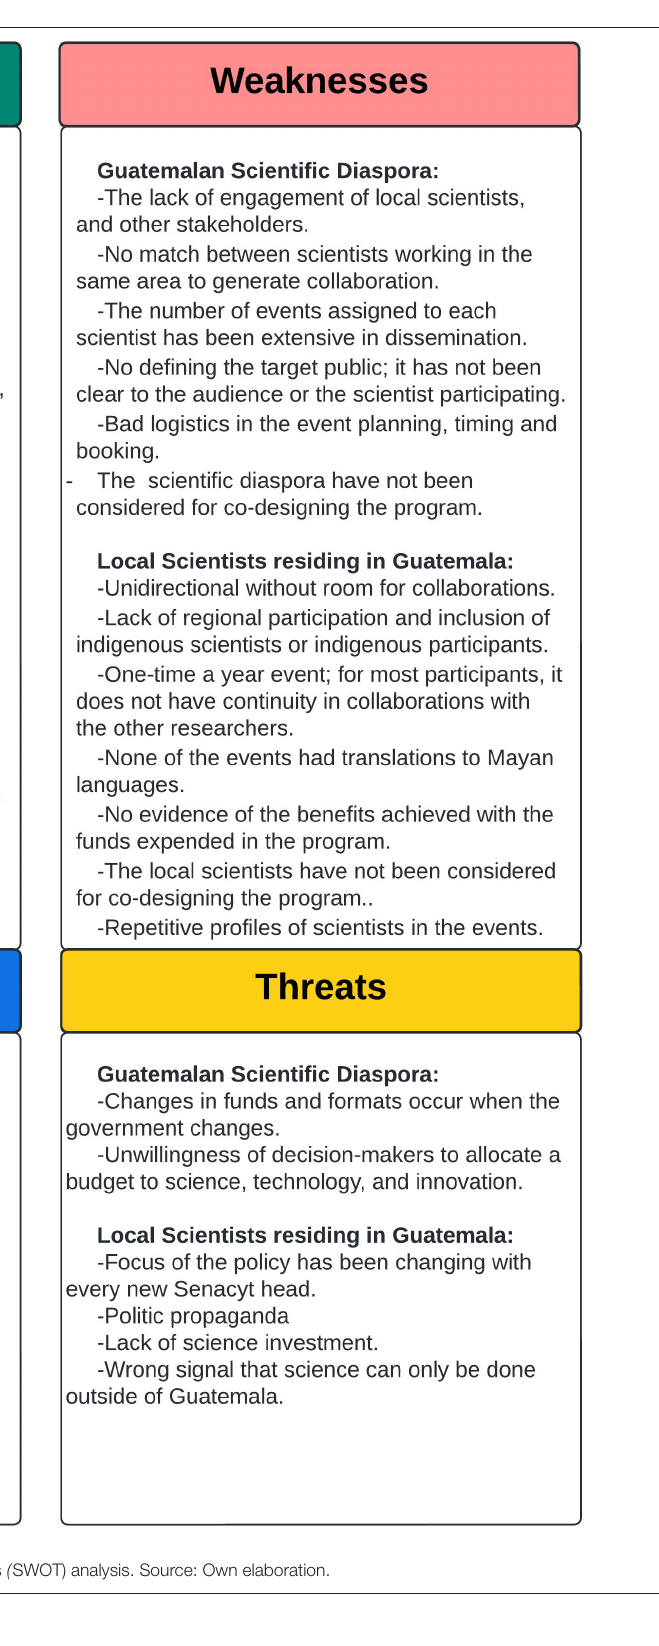
Frontiers in Research Metrics and Analytics |